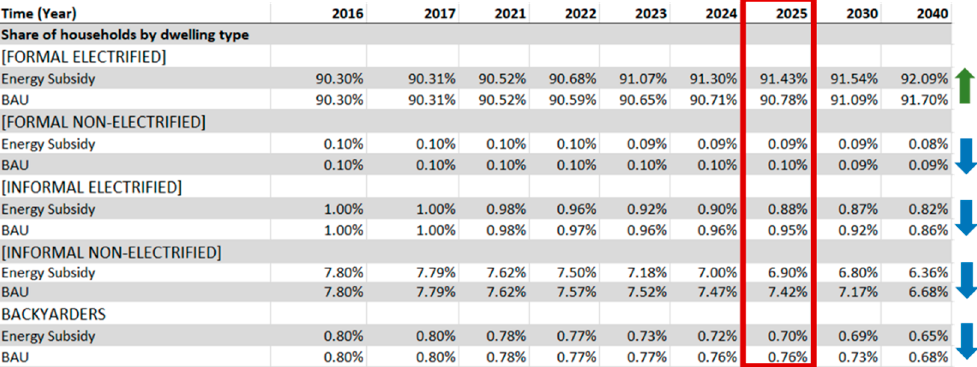
Figure 5. Share of households by dwelling type. Source: Authors.